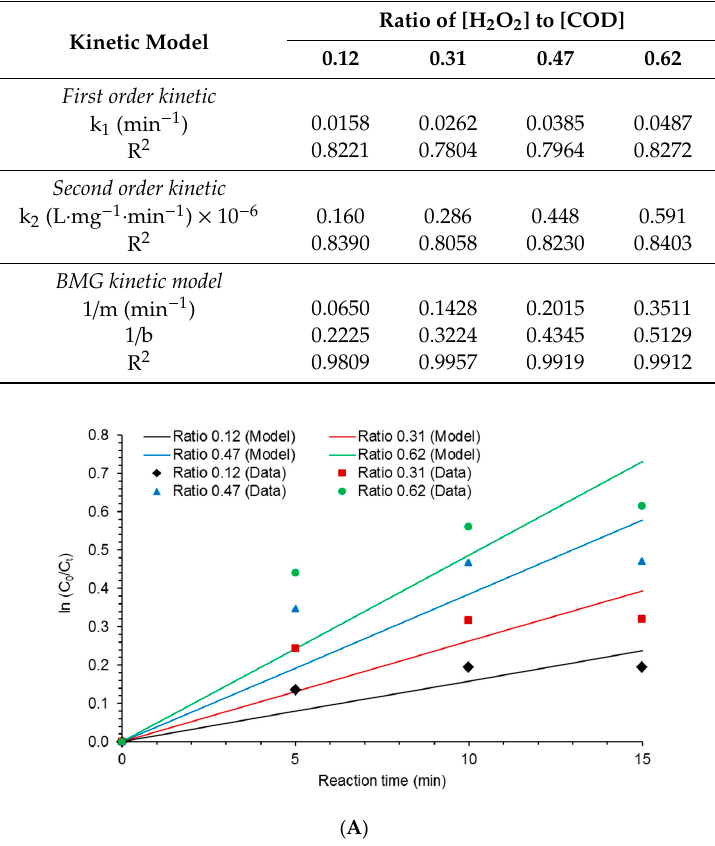
Table 2. Comparison of first order, second order, and BMG kinetic models for COD degradation at different [H 2 O 2 ] to [COD] ratios.